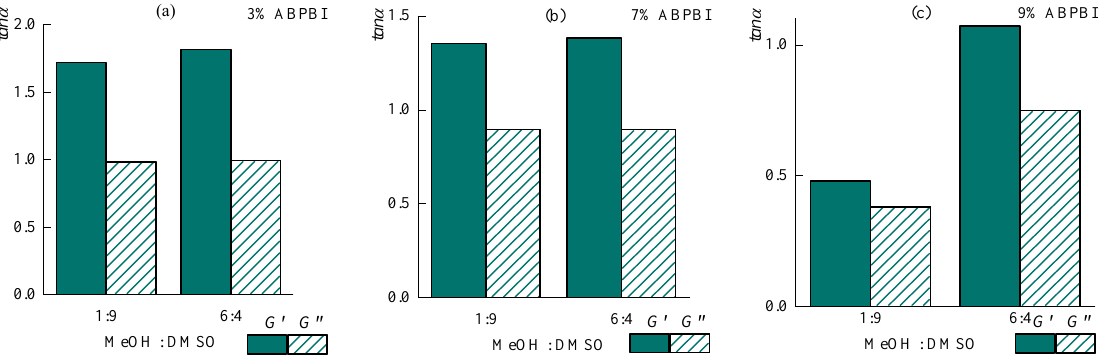
Figure 9. Dependence of the slope tangent of dynamic moduli in the low-frequency range on the MeOH:DMSO ratio, in solutions with a concentration of ( a ) 3, ( b ) 7, and ( c ) 9%.